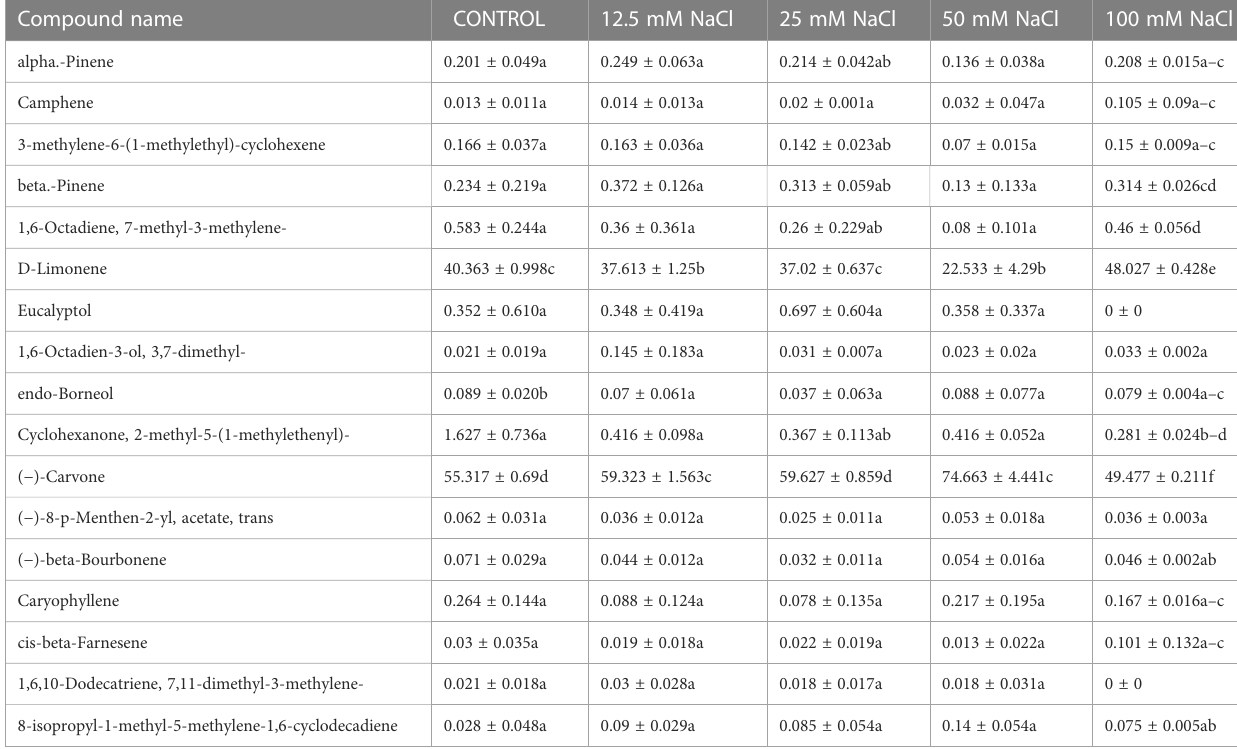
Means in the same column by the same letter are not signi fi cantly different to the test of Duncan ( a =